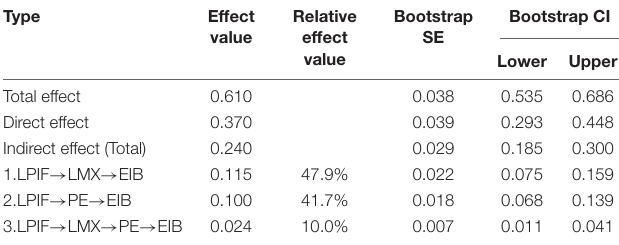
TABLE 4 | Bootstrap analysis of significance test of mediation